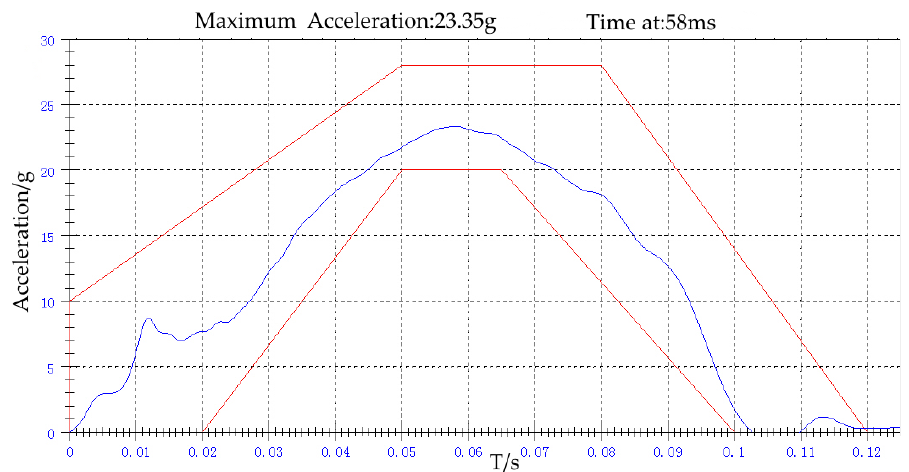
Figure 2. The acceleration pulse of sled test.